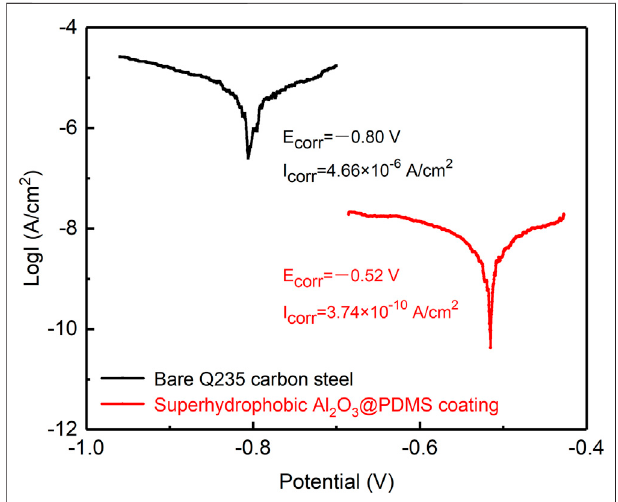
FIGURE 6 | Potentiodynamic polarization curves of the bare Q235 carbon steel and the as-prepared superhydrophobic Al 2 O 3 @PDMS coating with a scanning rate of 0.167